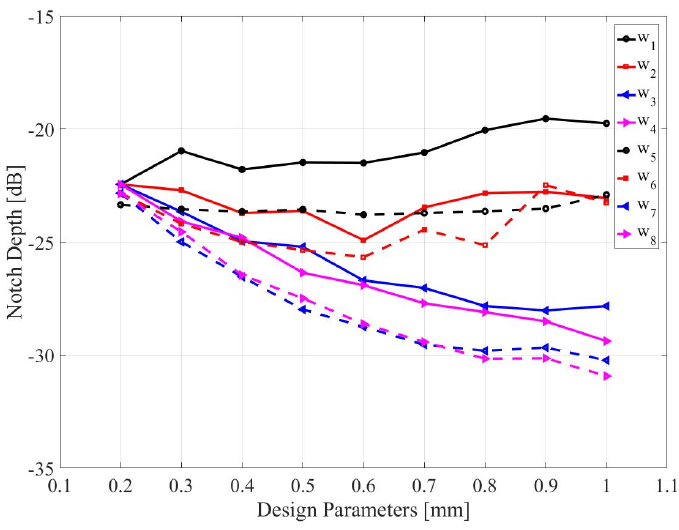
Figure 4. Variation in notch depth due to changes in the design parameters of CC ‐ SRR ( w 1 , w 2 , w 3 , and w 4 ) and SC ‐ SRR ( w 5 , w 6 , w 7 , and w 8 ).